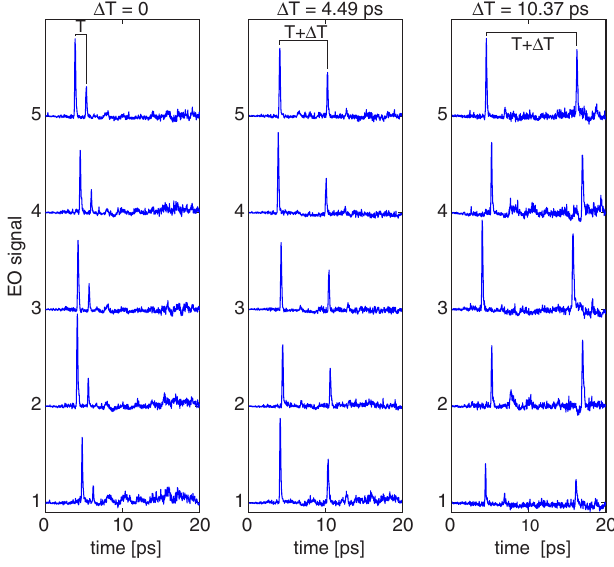
FIG. 10. (Color) Time calibration of EOTD measurements, see text for details. Fifteen single-shot electron bunch measurements are shown with duplicated gate pulses. Measurements have been performed in cross-polarizer geometry. Each column shows five measurements taken at the same T þ (cid:2) T delay between the gate pulses.